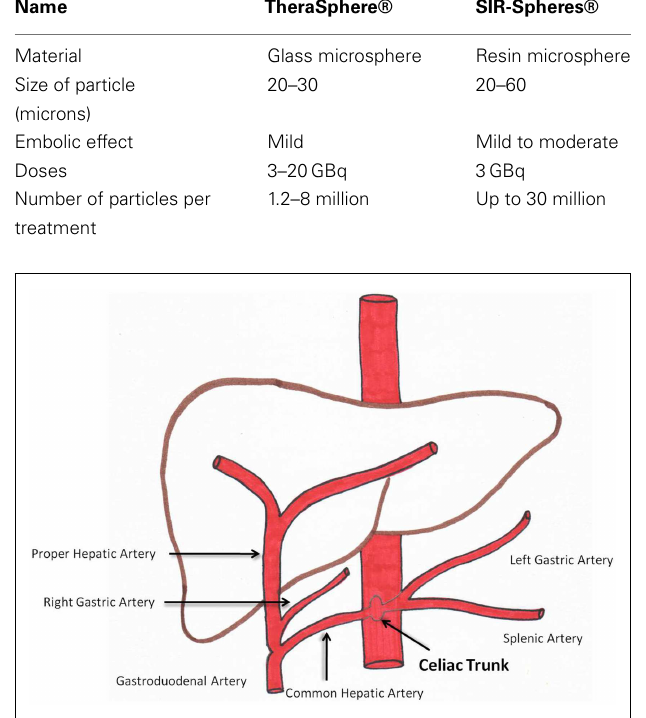
FIGURE 1 | Schematic representation of celiac arterial anatomy